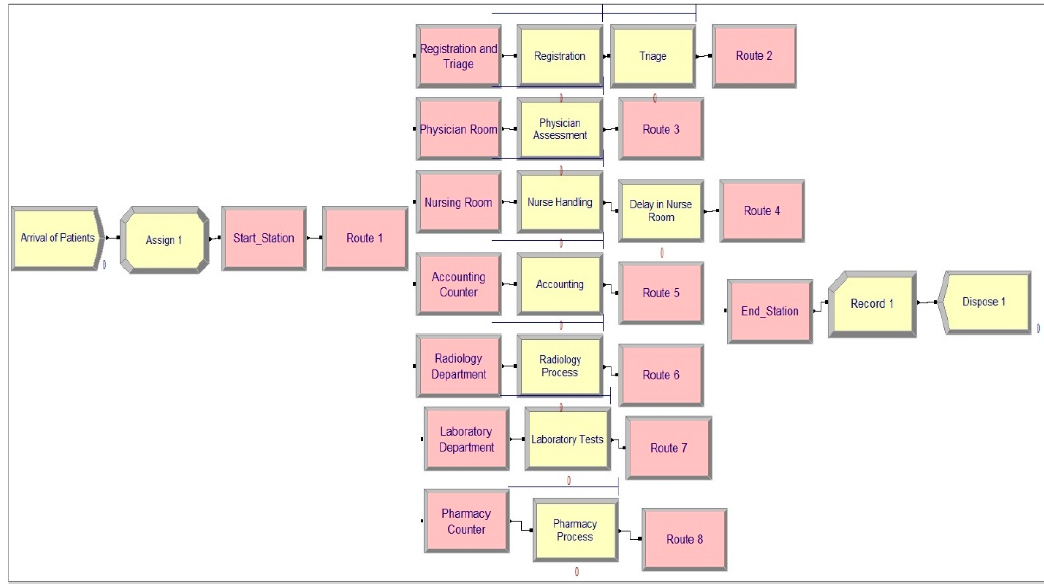
Figure 5. The constructed model using Arena software .